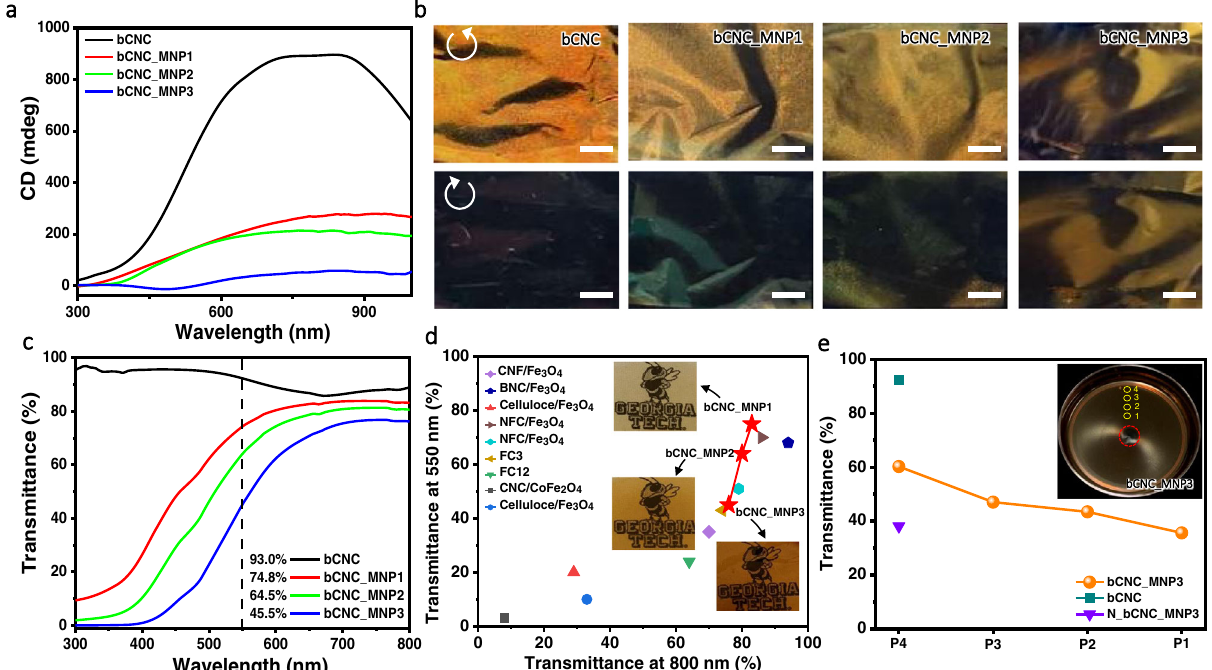
Fig. 4 |Opticalpropertiesofmagnetic fi lms.a CDspectraofthebCNC fi lmswith different loading with magnetic nanoparticles. b Photographs of all fi lms viewed under left-handed (top) and right-handed (bottom) circular polarizers. Scale bar: 5mm. c UV – vis spectra of the bCNC fi lms with different magnetic nanoparticle loadings and transmittance data at 550nm. d Comparison in the transmittances at